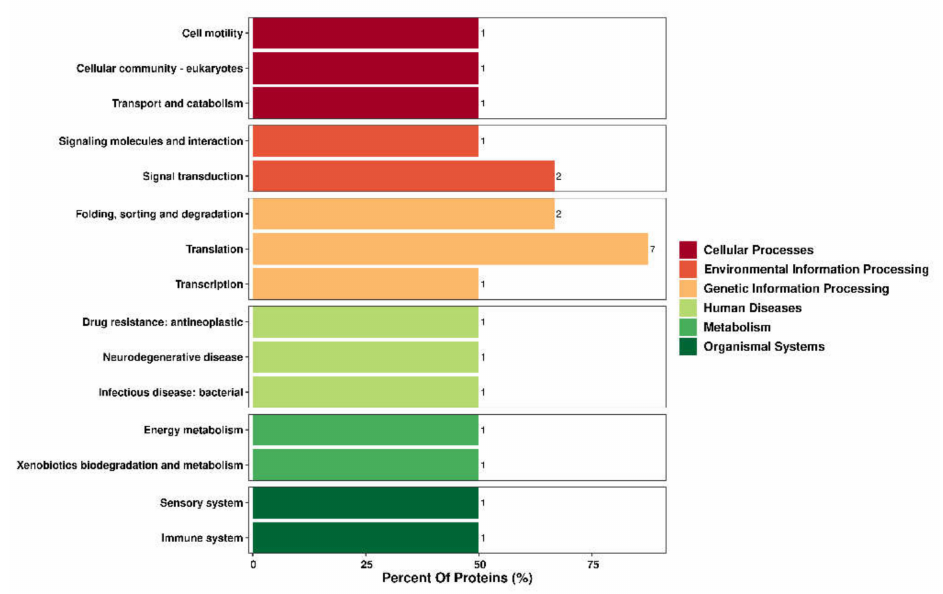
Figure 4. Kyoto Encyclopedia of Genes and Genomes (KEGG) annotation of differentially expressed proteins (DEPs). KEGG analysis of DEPs. The abscissa shows the percentage of DEPs, and the ordinate shows the the significantly enriched KEGG